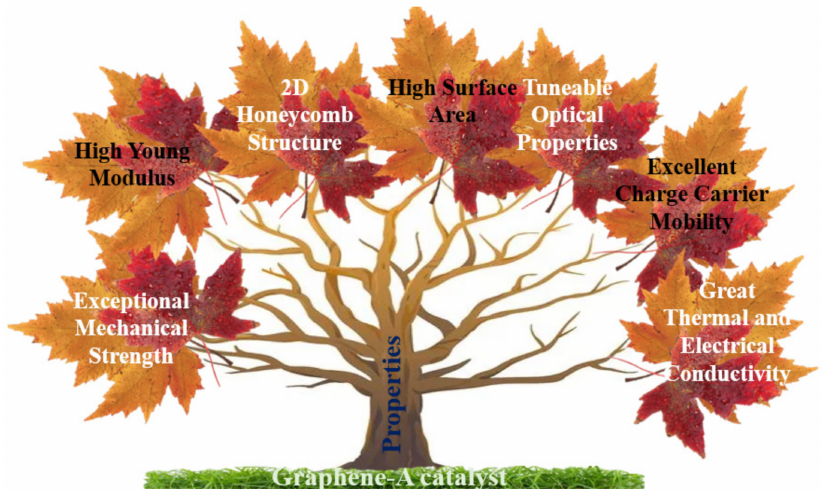
Figure 2. Diagrammatic representation of multi-functional properties of